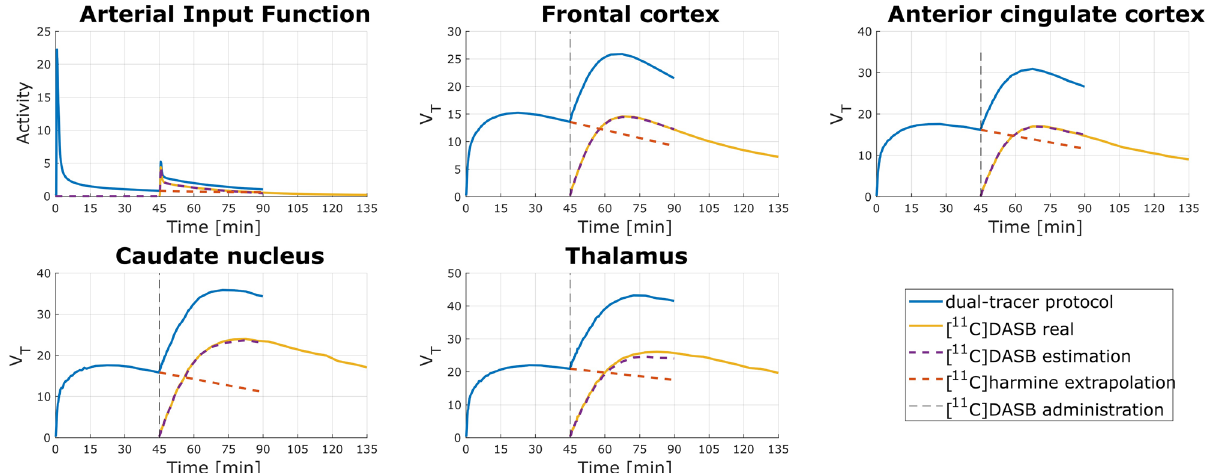
Figure 4. Example TACs and AIFs (top left) when [ 11 C]harmine was applied as first. Blue lines TAC HAR_DASB and AIF HAR_DASB are representing dual-tracer application, yellow lines are showing TAC DASB and AIF DASB of 90 min [ 11 C]DASB measurement, purple dashed lines shows a time course of simulated TAC DASB_est and AIF DASB_est and the red dashed line express extrapolated TAC HAR_ext and AIF HAR_ext . A black vertical dashed line denotes the administration of [ 11 C]DASB.